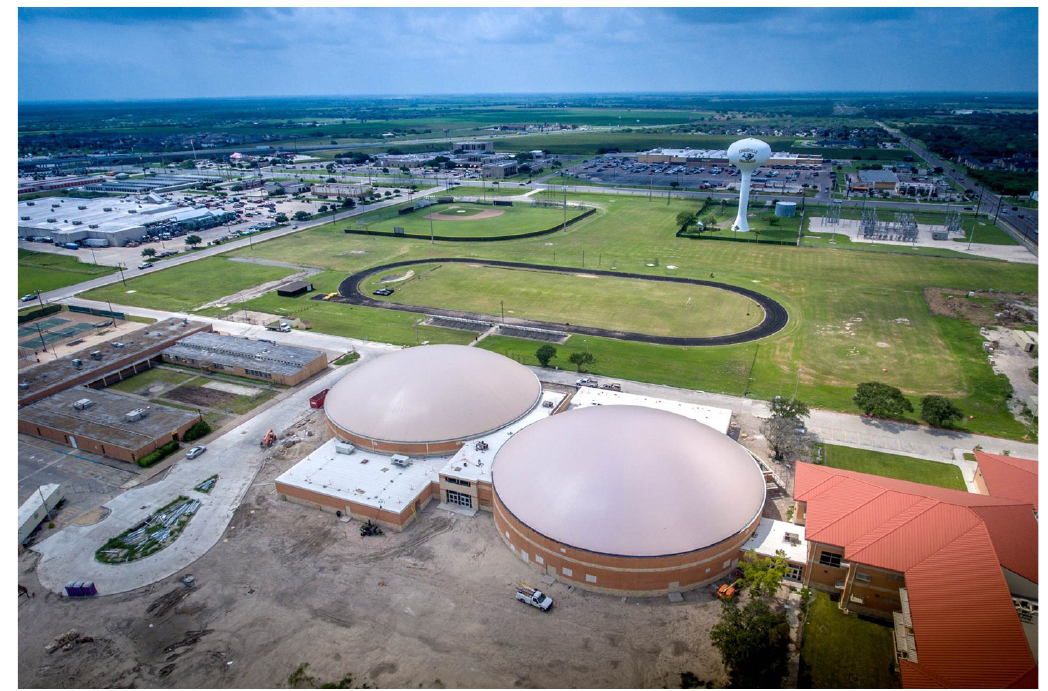
Figure 6. Kingsville Independent School District Community storm shelter in Kingsville, Texas, on the Gulf Coast. Source: Dome Technology (2021).